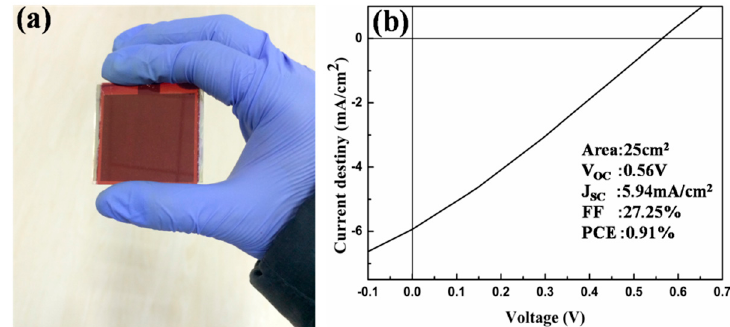
Figure 7. ( a ) Image of a 25 cm 2 OSC device with as-grown S-WO 3 film and ( b ) J–V characteristic of the OSC.